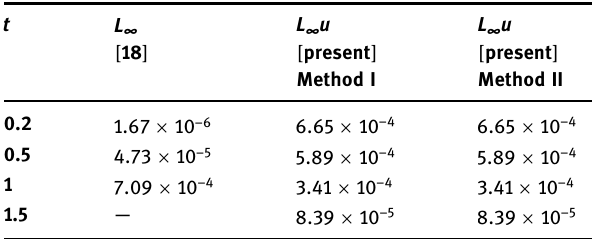
Table 12: Comparison of maximum absolute error at di ff erent time levels for = α 10 , = β 5 , = N 101 , = τ 0.5 , and = t Δ 0.0001